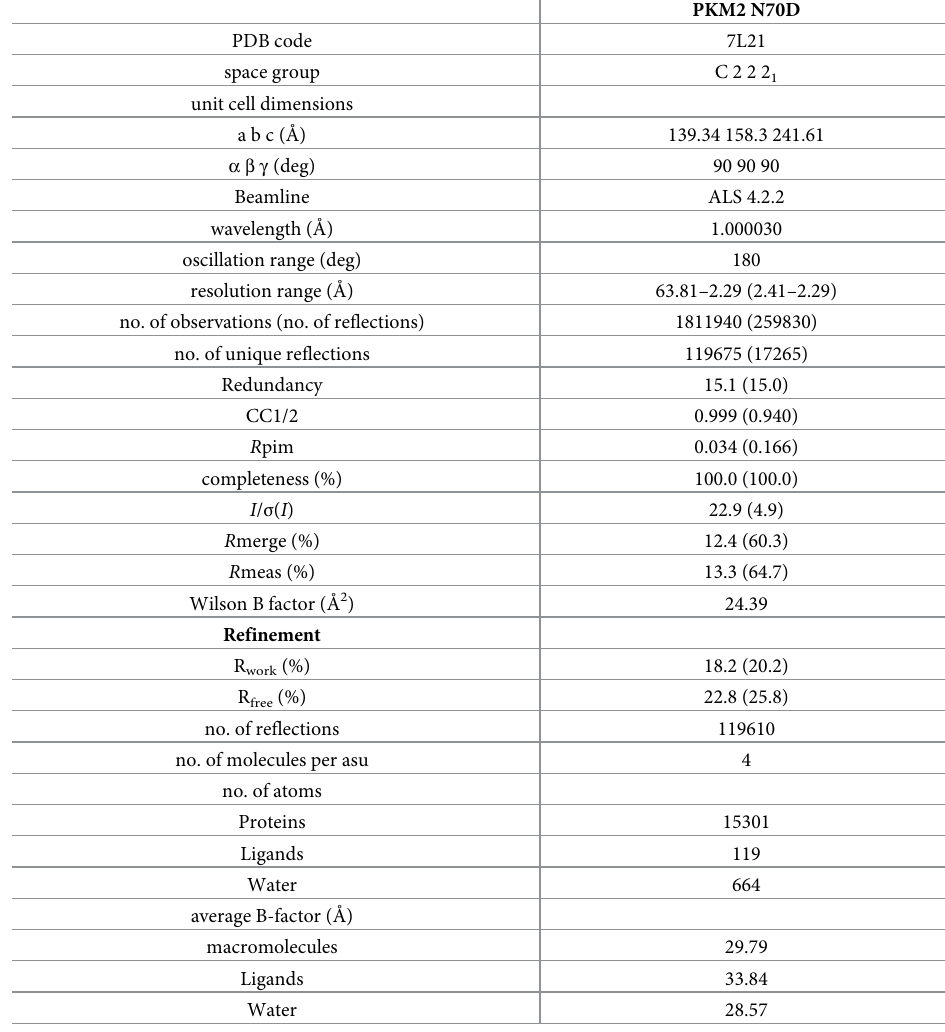
Table 1. X-ray data collection and refinement